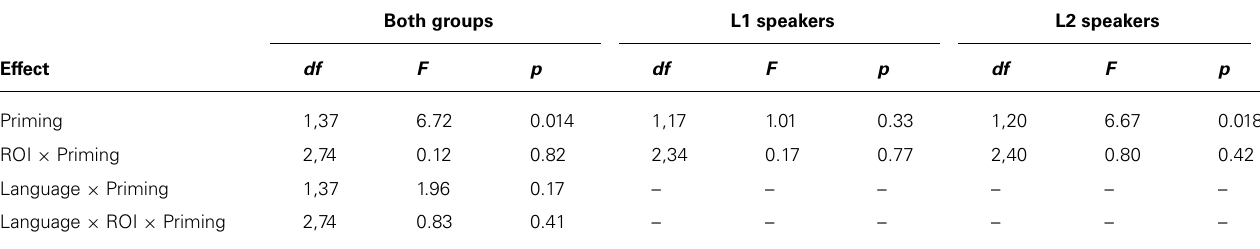
Table 3 | ROI analyses. Repeated-measuresANOVAs on contrast values for complex verbs. Both groups